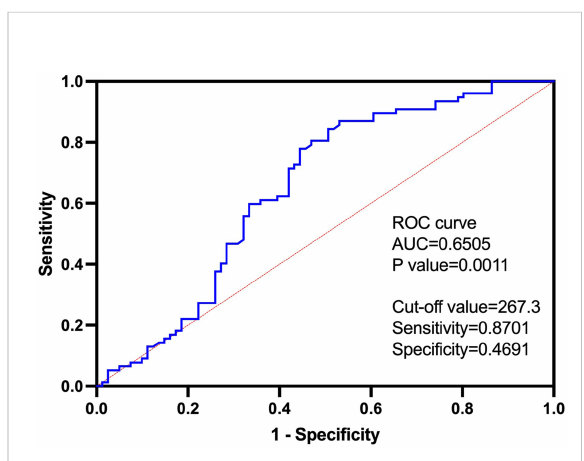
FIGURE 3 The receiver operating characteristic (ROC) curve of Leukocyte ImmunoTest (LIT) in predicting malignant tumor, with cutoff value of 267.3, sensitivity of 0.8701, and speci fi city of 0.4691. The area under the curve (AUC) was 0.6505. Positive predictive value of LIT on tumor being malignant is 63%, and negative predictive value is